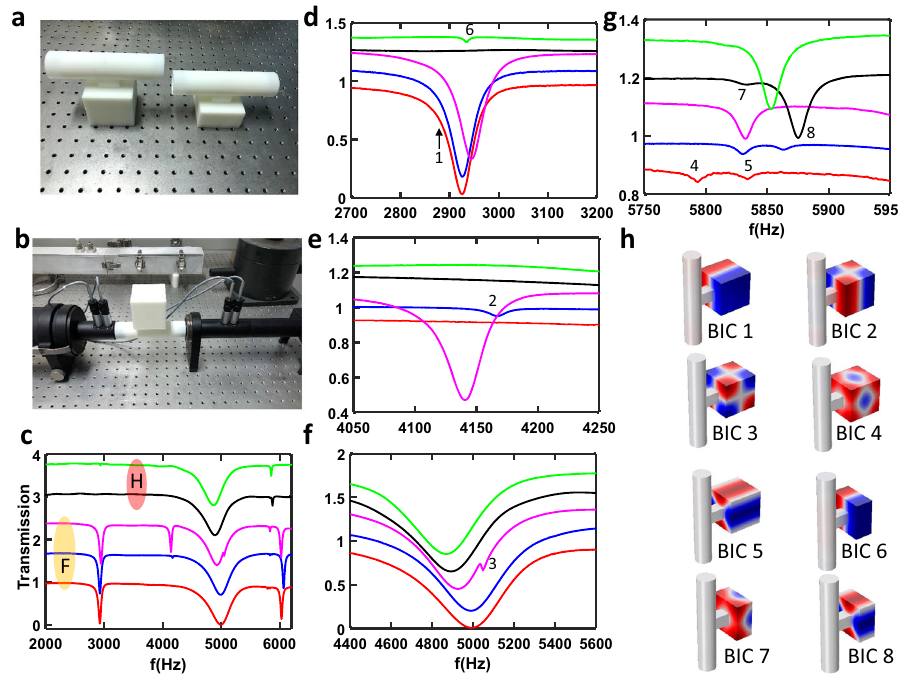
Fig. 3 Experimental veri fi cation in an open resonator. a Image of 3D printed full (left) and half (right) acoustic resonator. b Transmission measurement system. c Full transmission spectrum in the frequency range 2000 – 6000 Hz. Red, blue and magenta lines represent full resonator ( Lx = Ly = Lz = 60 mm) with y c = z c = 0 mm, y c = 1 mm and z c = 0 mm, and y c = z c = 4 mm, respectively; Black and green lines represent half resonator ( Lx = 30 mm, Ly = Lz = 60 mm) with y c = z c = 0 mm, and y c = 1 mm and z c = 0 mm. Eight BICs are observed and labelled as 1 – 8. d – g zoom in transmission spectrum in the frequency range 2700 – 3200 Hz ( d ), 4050 – 4250 Hz ( e ), 4400 – 5600 Hz ( f ), and 5750 – 5950 Hz ( g ). h pressure fi eld distribution of eight BICs in the full and half resonator, which is also correlated to peaks 1 – 8 in the transmission